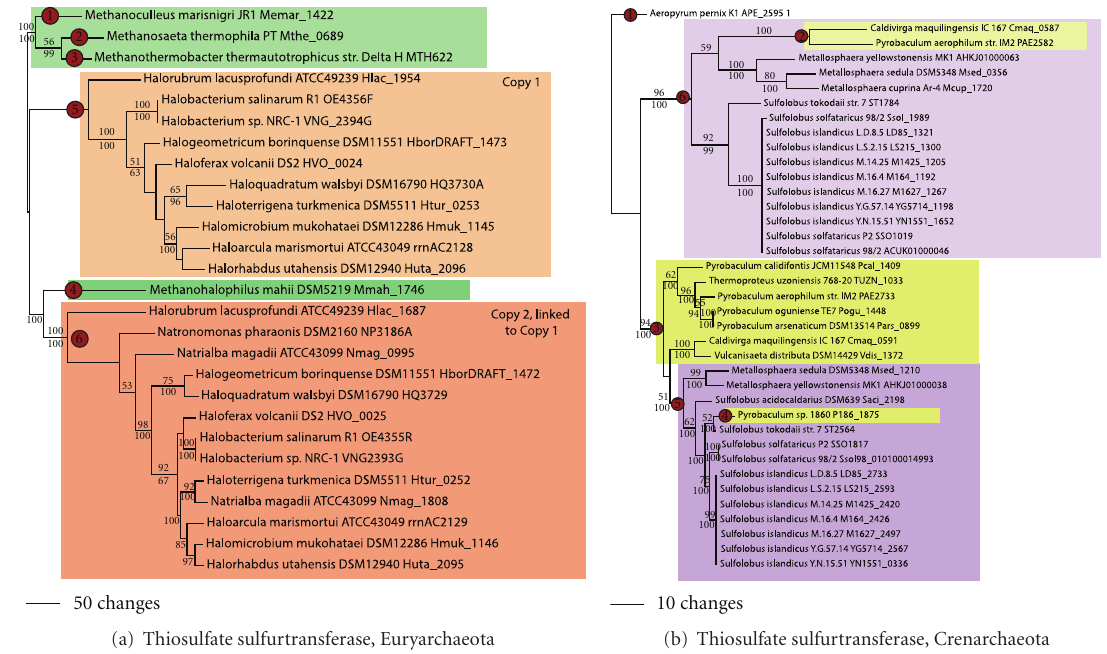
Figure 7: Thiosulfate reduction. Thiosulfate sulfurtransferase (SseA) phylogeny for (a) the Euryarchaeota and (b) Crenarchaeota.